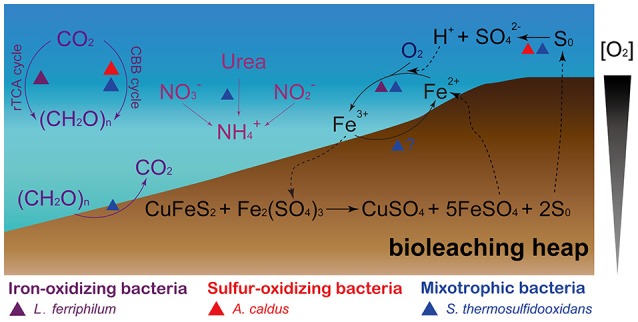
Schematic representation showing the microbe-mediated biogeochemical cycle of main elements (carbon, nitrogen, iron, and sulfur) in bioleaching heaps. The figure was adapted from Johnson (1998), Baker and Banfield (2003), and Chen et al. (2016).